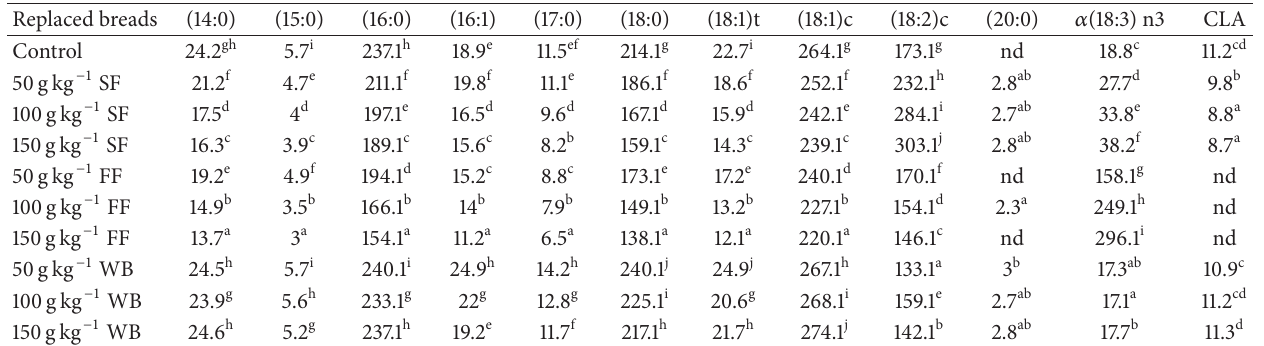
Table 2: Fatty acid composition (g kg − 1 of total fatty acids) of loaves replaced with SF, FF, and WB (50, 100, and 150 gkg −1 ) and control a . Replaced breads Control